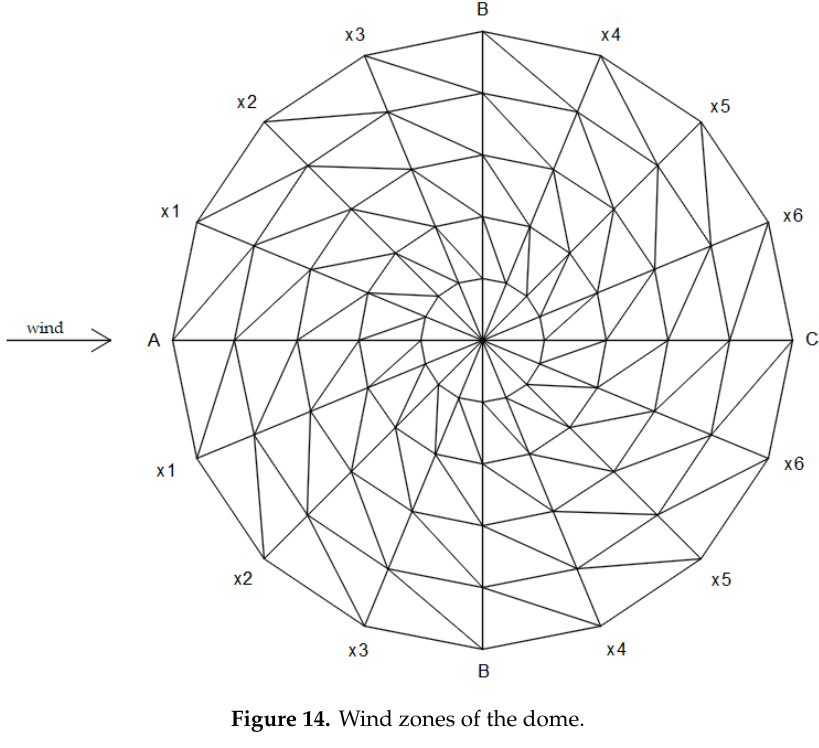
Figure 14. Wind zones of the dome.